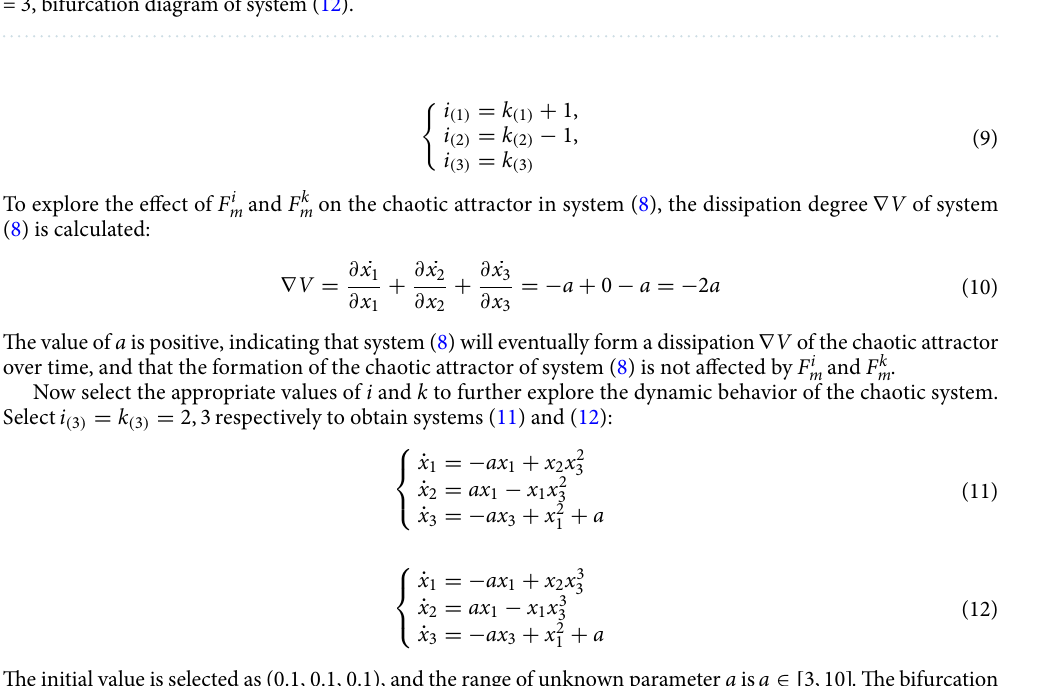
Figure 6. Bifurcation diagrams of systems (11) and (12). ( a ) i ( 3 ) = 2, bifurcation diagram of system (11). ( b ) i ( 3 ) = 3, bifurcation diagram of system